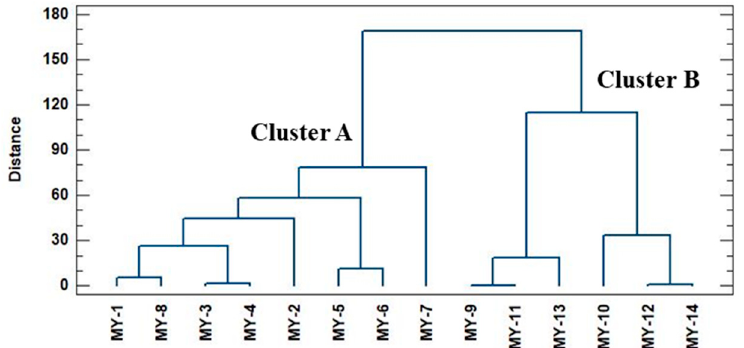
Figure 4. Dendrogram obtained by a hierarchical cluster analysis, based on the chemical parameters studied of the 14 samples by duplicated myrtle pulp extracts.